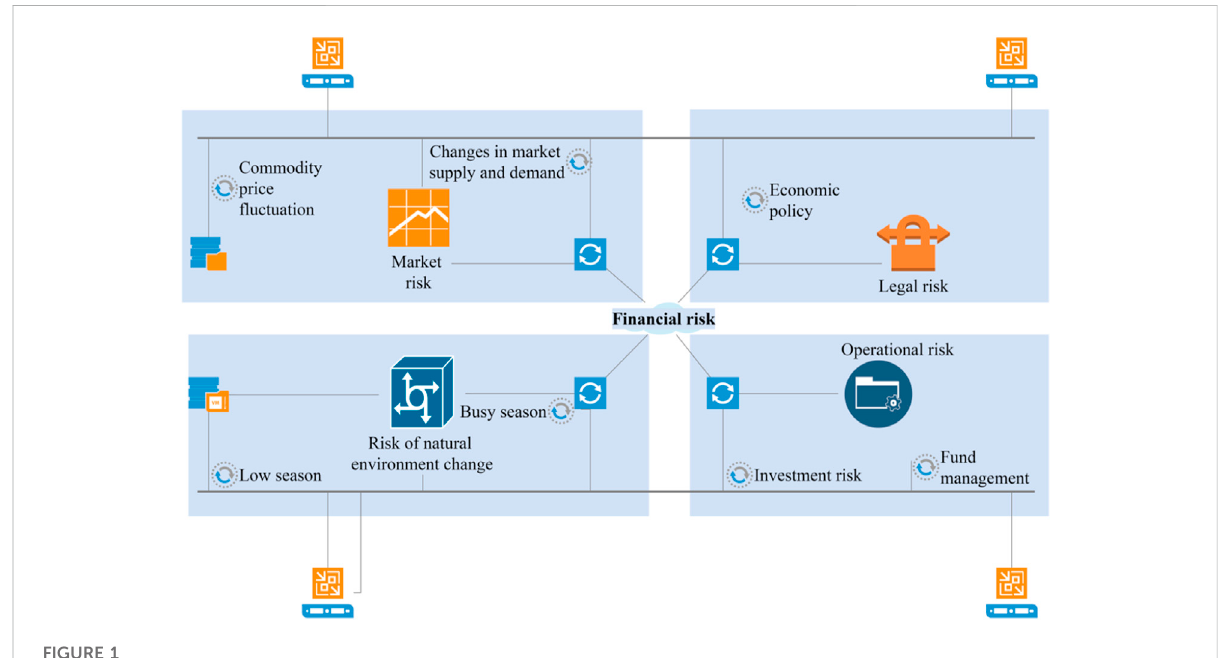
FIGURE 1 Types of corporate fi nancial